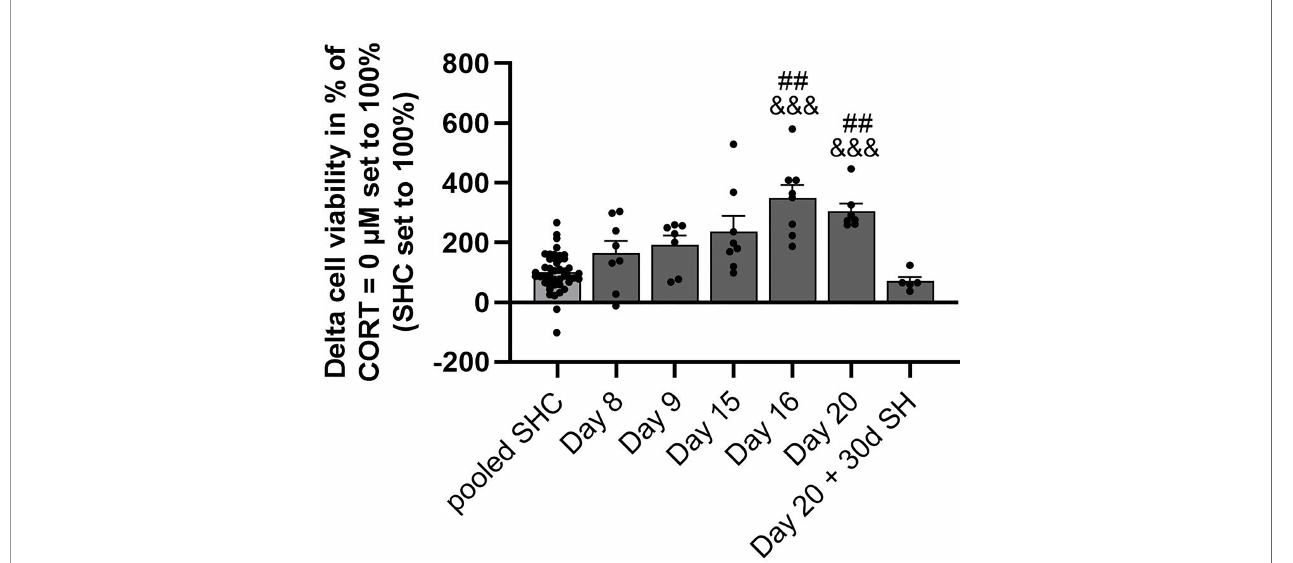
FIGURE 4 | Analysis of CSC-induced GC resistance throughout all time points assessed. Depicted is the delta cell viability (Lipopolysaccharide (LPS)-stimulated minus basal conditions) of isolated and in vitro stimulated splenocytes of CSC and SHC mice at 0.1 µM corticosterone (CORT; CORT = 0 µM set to 100%) concentration. The single-housed control (SHC) mice of each time point were set to 100%. Data are presented as mean + SEM including individual values. ## P ≤ 0.01 versus day 20 + 30d of single housing (SH); &&& P ≤ 0.001 versus pooled